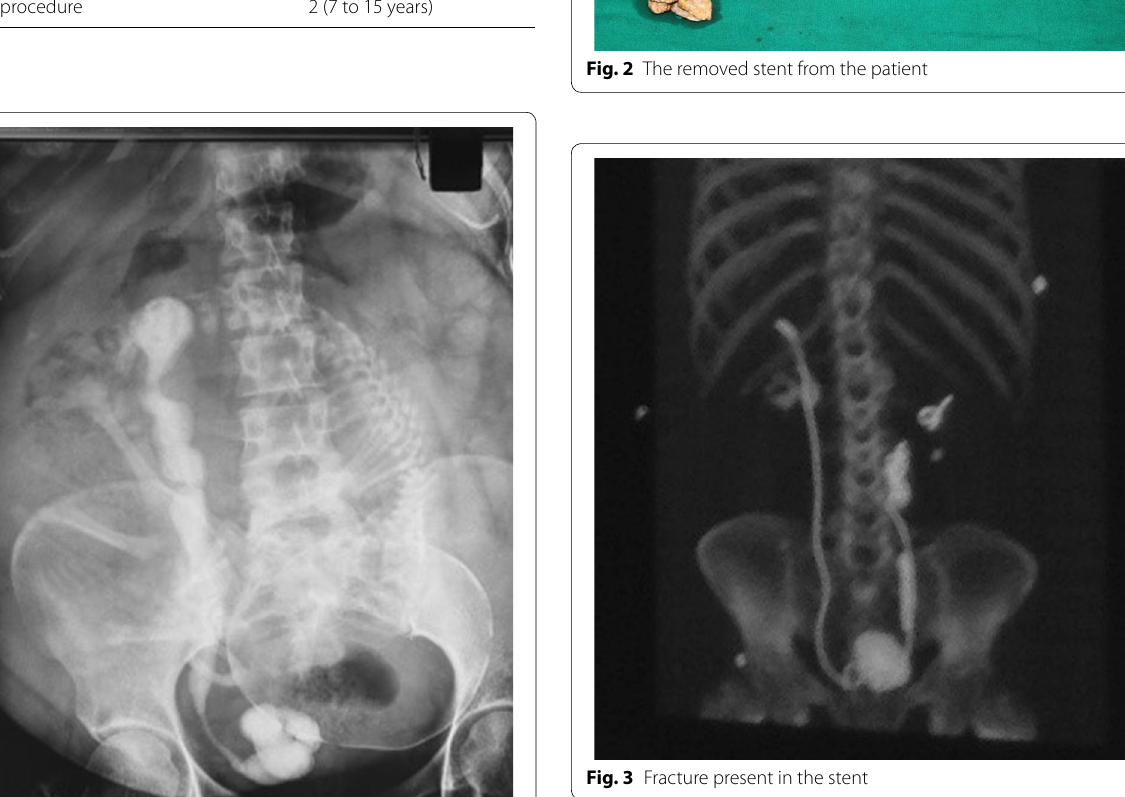
patient had fractured upper end of stent on both sides (Fig. 3). She required CLT, open ureterolithotomy and PCNL for complete removal of stent on the left side and cystoscopy with DJ stent removal and PCNL on the right side. Several complications were noted during or after forgotten stent removal like fever (10%), sepsis (3.34%),